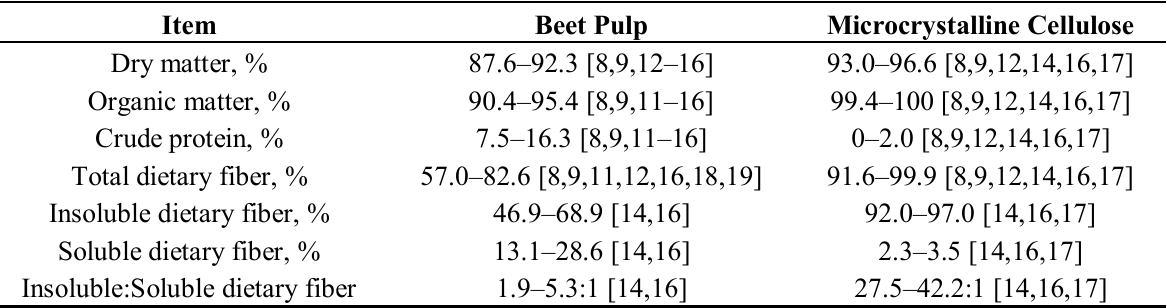
Table 1. Chemical composition of beet pulp and microcrystalline cellulose as reported in the